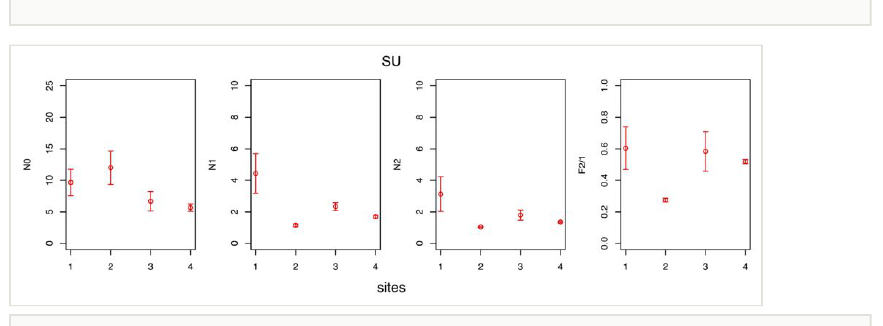
Figure 8. Variability of the observed species diversity and eveness along the sites (1, 2, 3, 4) transect during the summer (SU) survey. Diversity was measured using the Hill numbers N0, N1 and N2, whereas eveness was measured with the F2/1 index.